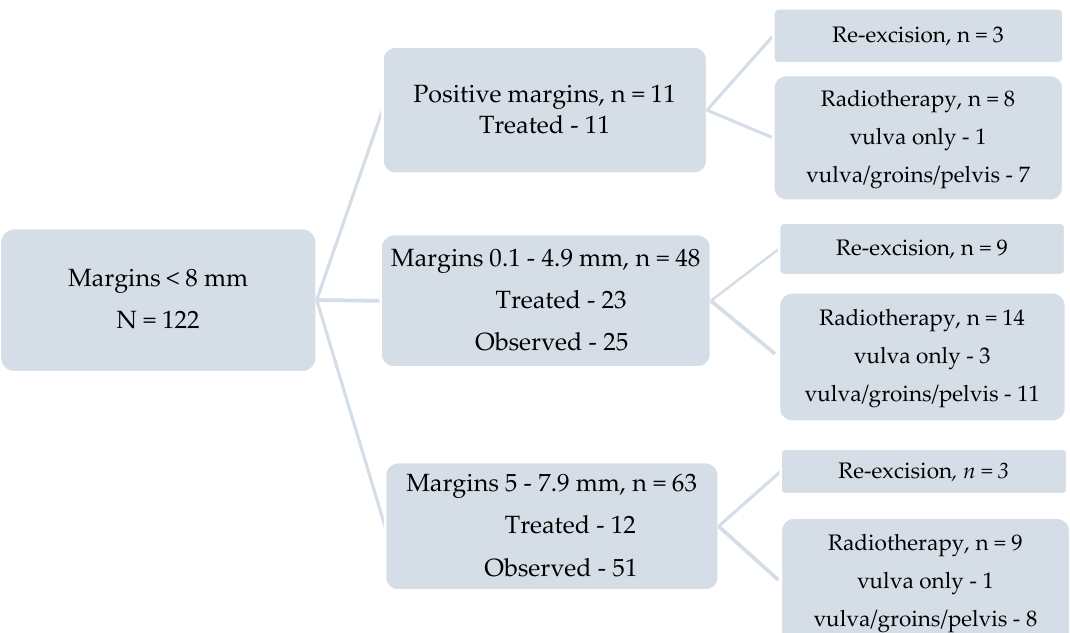
Figure 3. The relationship between surgical margins <8 mm and subsequent management.